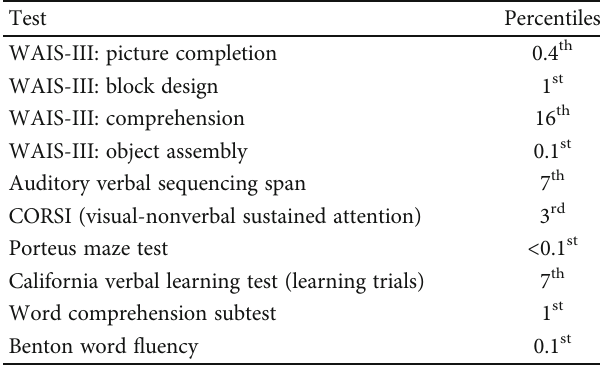
Table 1: Results of neuropsychological testing